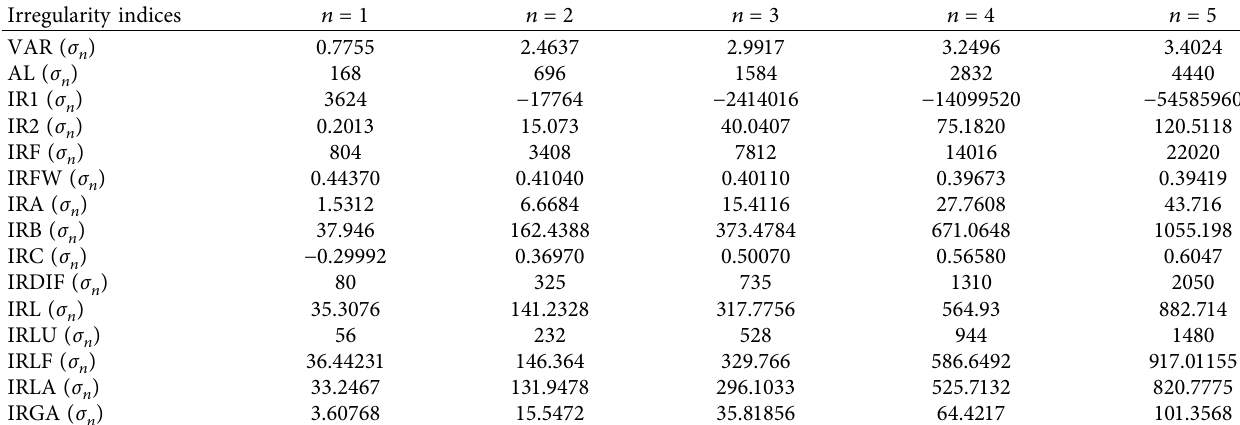
Table 4: Numerical values of irregularity indices for σ